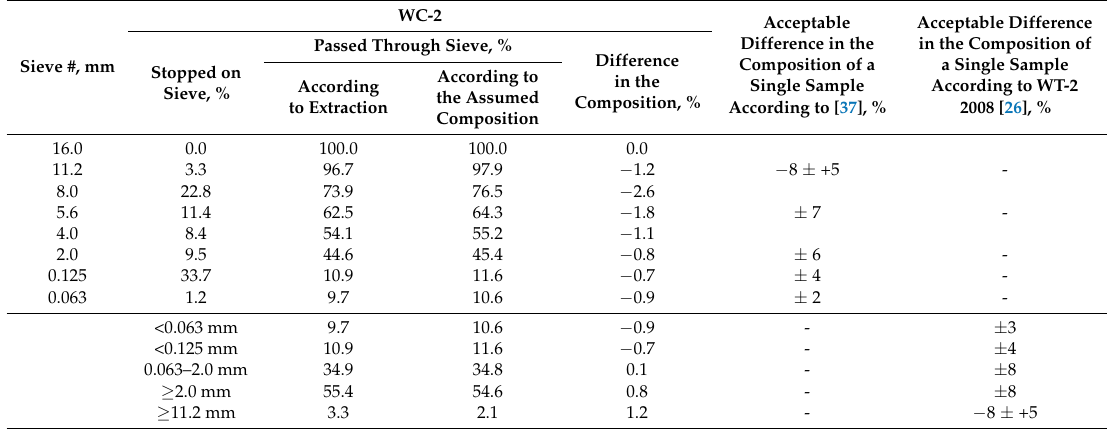
Table 9. Aggregate graining following extraction for WC-2.